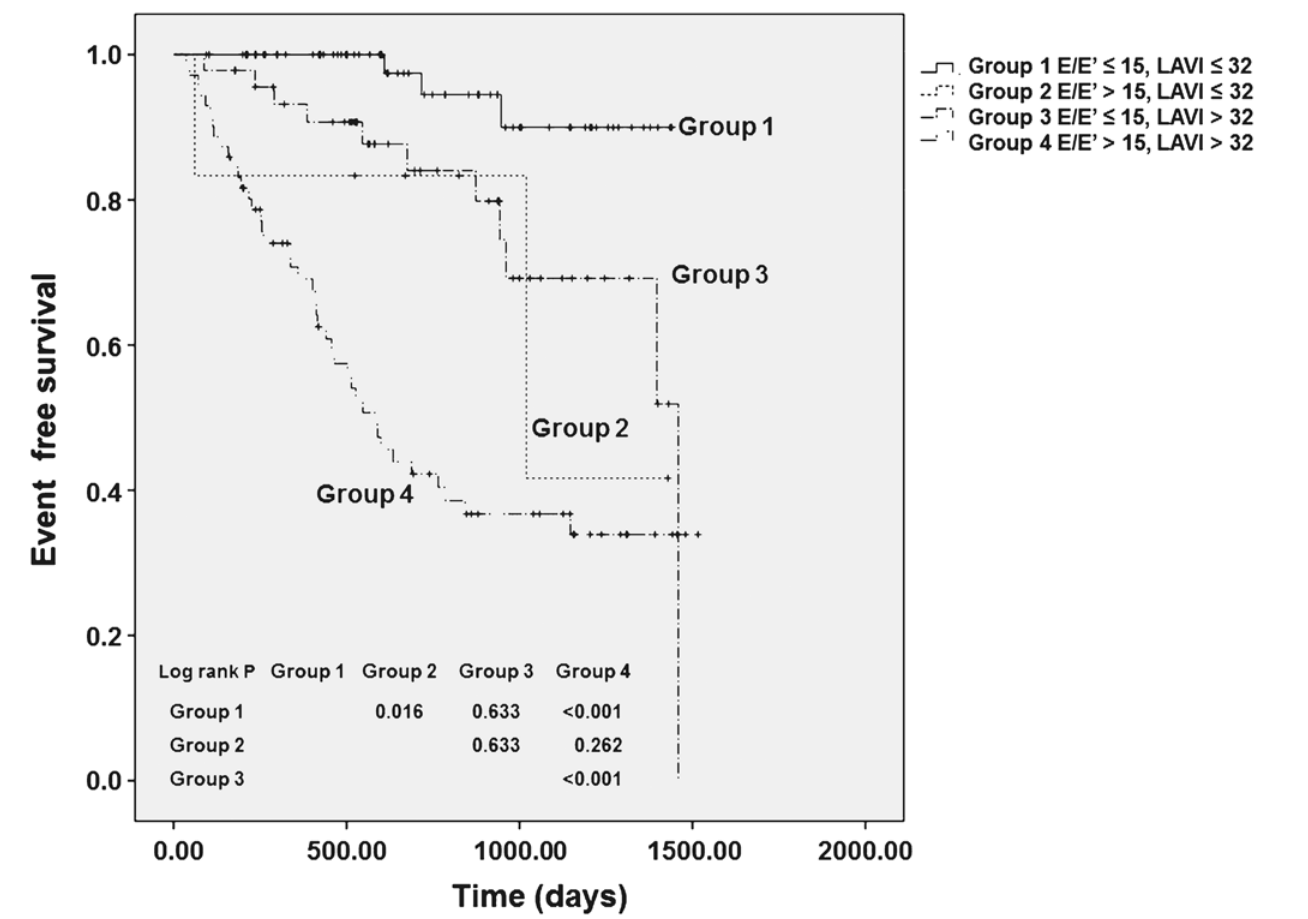
Fig 1. Kaplan-Meier survival curves for CV events according to E/E ’ ( > 15) and LAVI ( > 32 mL/m 2 ).